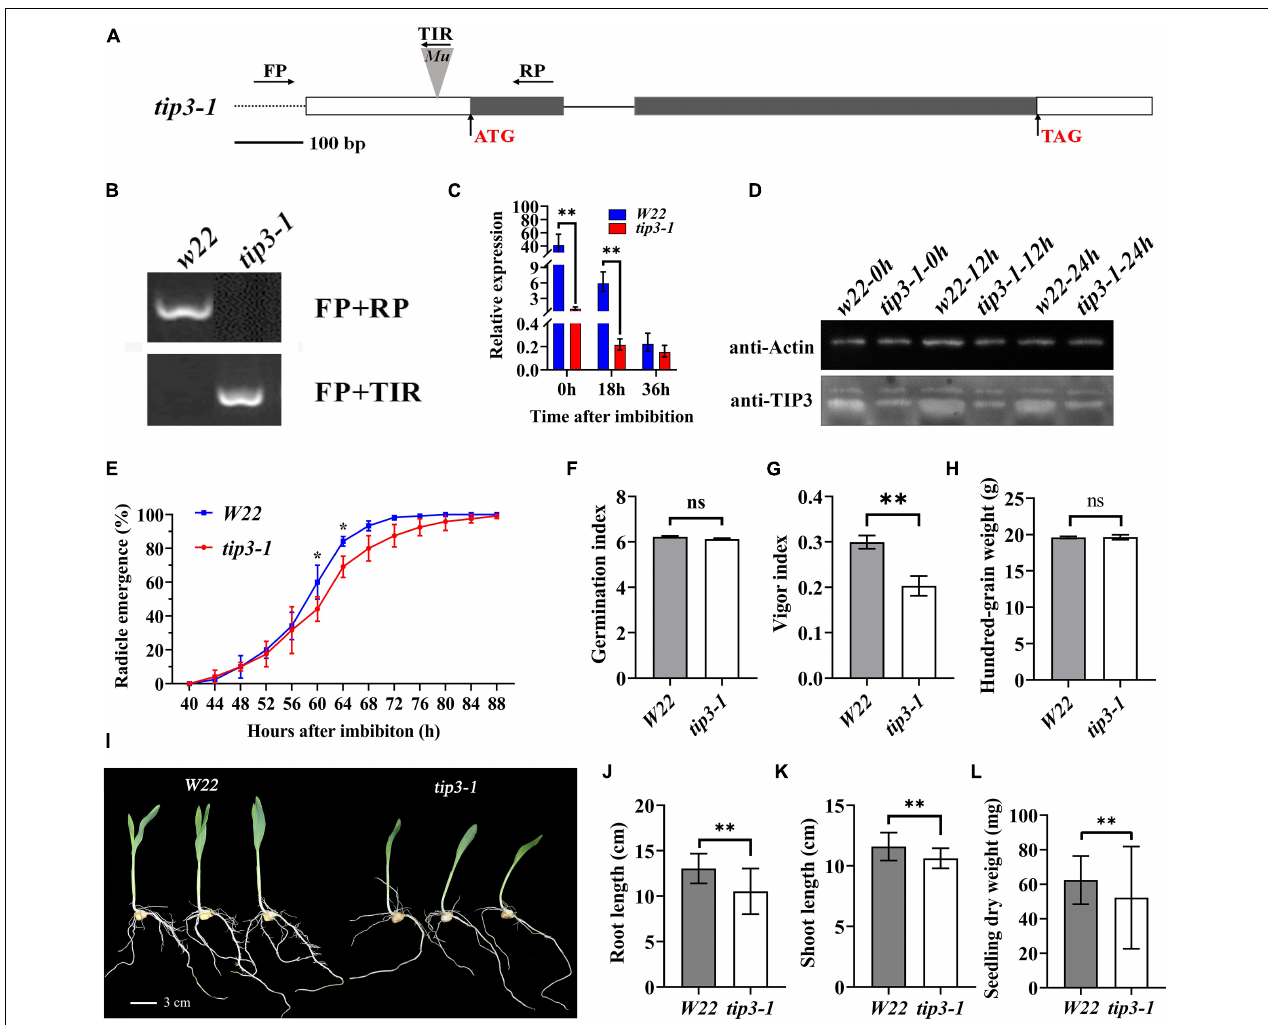
FIGURE 5 | Phenotypic analysis of the zmtip3-1 mutant. (A) Gene structure of the ZmTIP3-1 and Mu insertion sites. Exons are shown as black boxes and introns as lines. The 5’ UTR and 3’ UTR are shown as white boxes. The Mu insertion site and primer sites are indicated. (B) Identification of the mutant by PCR at the genome level. (C) qRT–PCR analysis of ZmTIP3-1 transcript abundance in W22 and zmtip3-1 seeds. The samples were collected at 0, 18, and 36 h after imbibition. ACTIN 1 was used as an internal control. Data are means ± SD . (D) Immunoblot analysis of anti-TIP3 in zmtip3-1 and W22 . Anti-actin antibody was used as the internal control. Total proteins were extracted from whole seeds at 0, 12, and 24 h after imbibition. (E) Comparison of the germination rate between zmtip3-1 and W22 . Radicle emergence characteristics were recorded every 4 h after imbibition. Radicle emergence is defined as radicle length > 2 mm. Data are means ± SD ( n = 3). There were three biological replicates and each included 100 grains. Comparison of the germination index (GI, F ), vigor index (VI, G ), and 100-grain weight (H) between zmtip3-1 and W22 . Seedling growth (I) , root length (J) , shoot length (K) and seedling dry weight (L) in zmtip3-1 and W22 at 7 days after imbibition. ∗ and ∗∗ indicate the significant differences at 5 and 1% levels, respectively, according to Student’s t -test, ns indicates